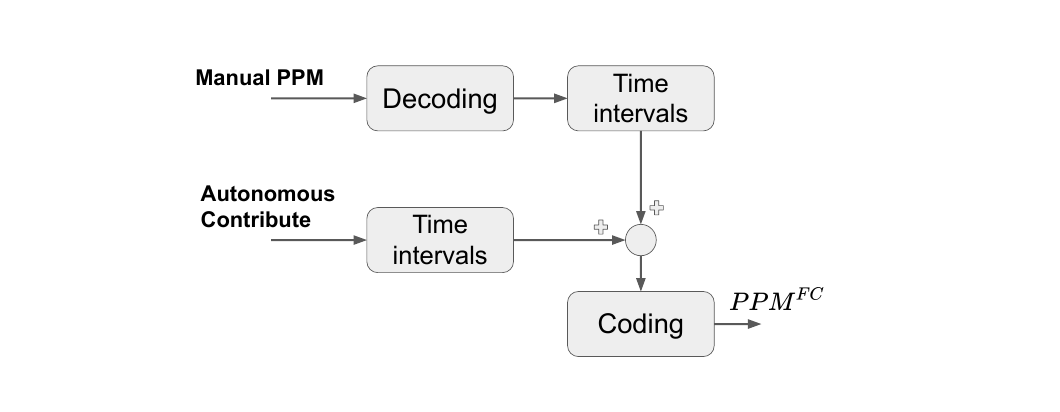
Figure 3. Functional scheme of the mixer board. The two input command signals, converted in time intervals, are merged into a single signal at the output of the board. We have named this operating logic as Hybrid Mode